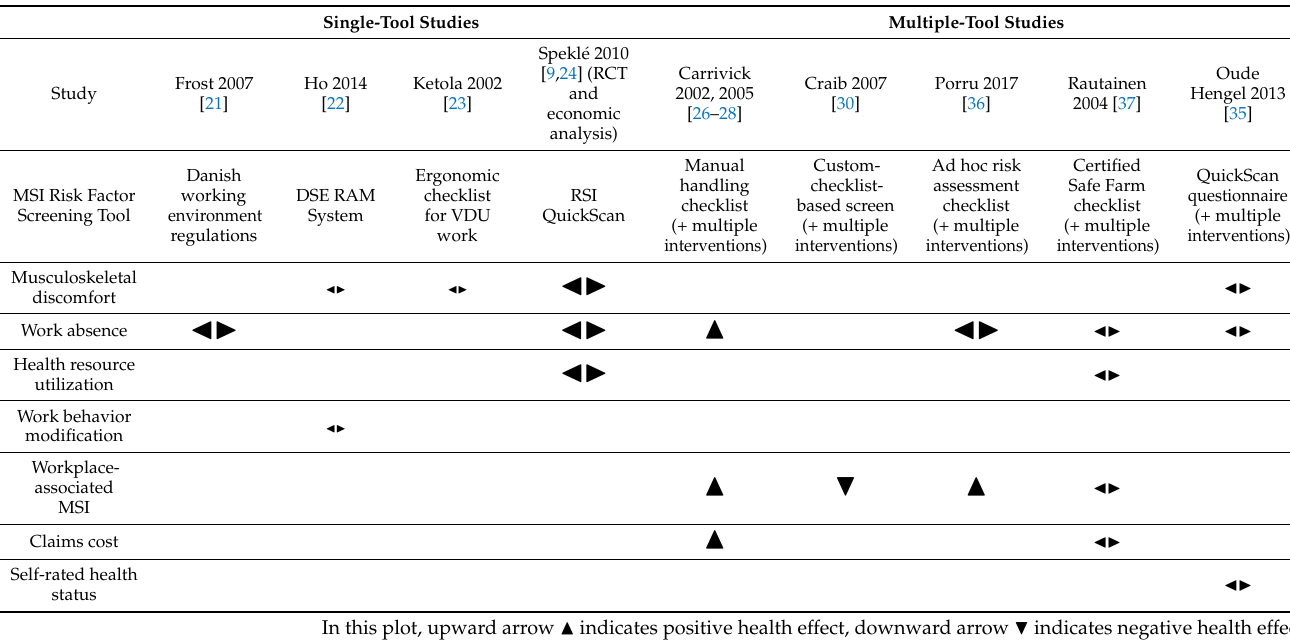
Table 2. Effect direction plot for retained included